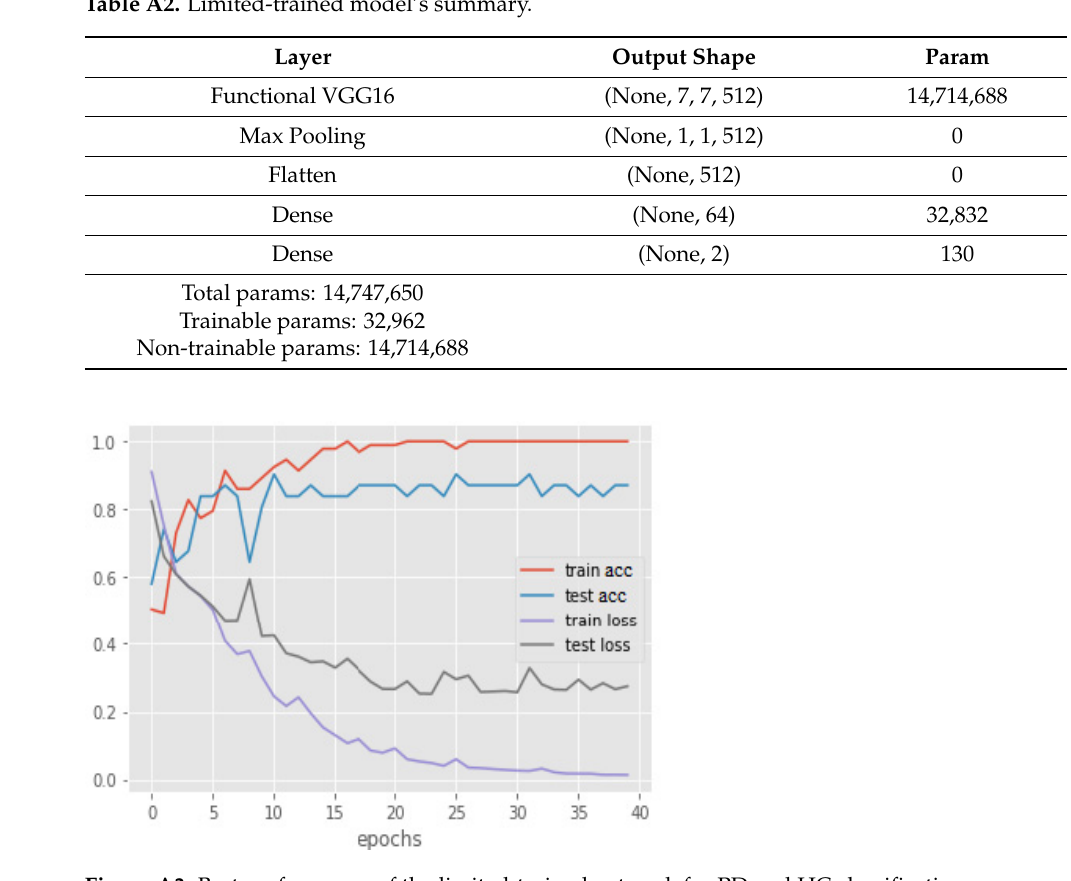
Figure A3. Best performance of the limited-trained network for PD and HC classification.